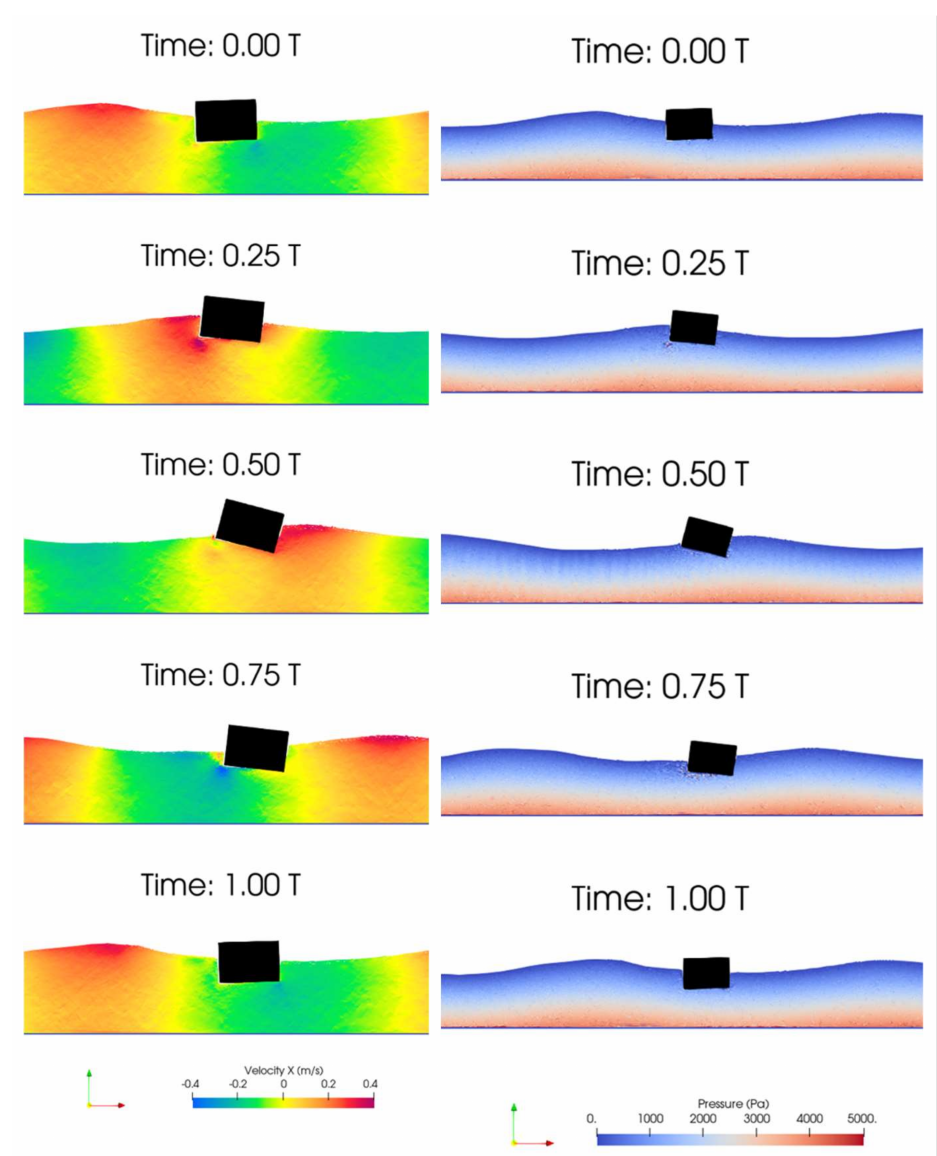
Figure 6. Different snapshots of the freely floating box under regular waves. Particle colors corre- spond to the horizontal flow velocity ( left ) and pressure ( right )